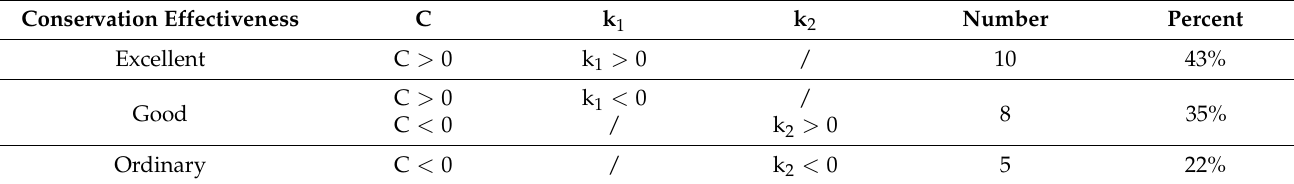
Table 8. Criteria and results of conservation effectiveness evaluation of reserves.